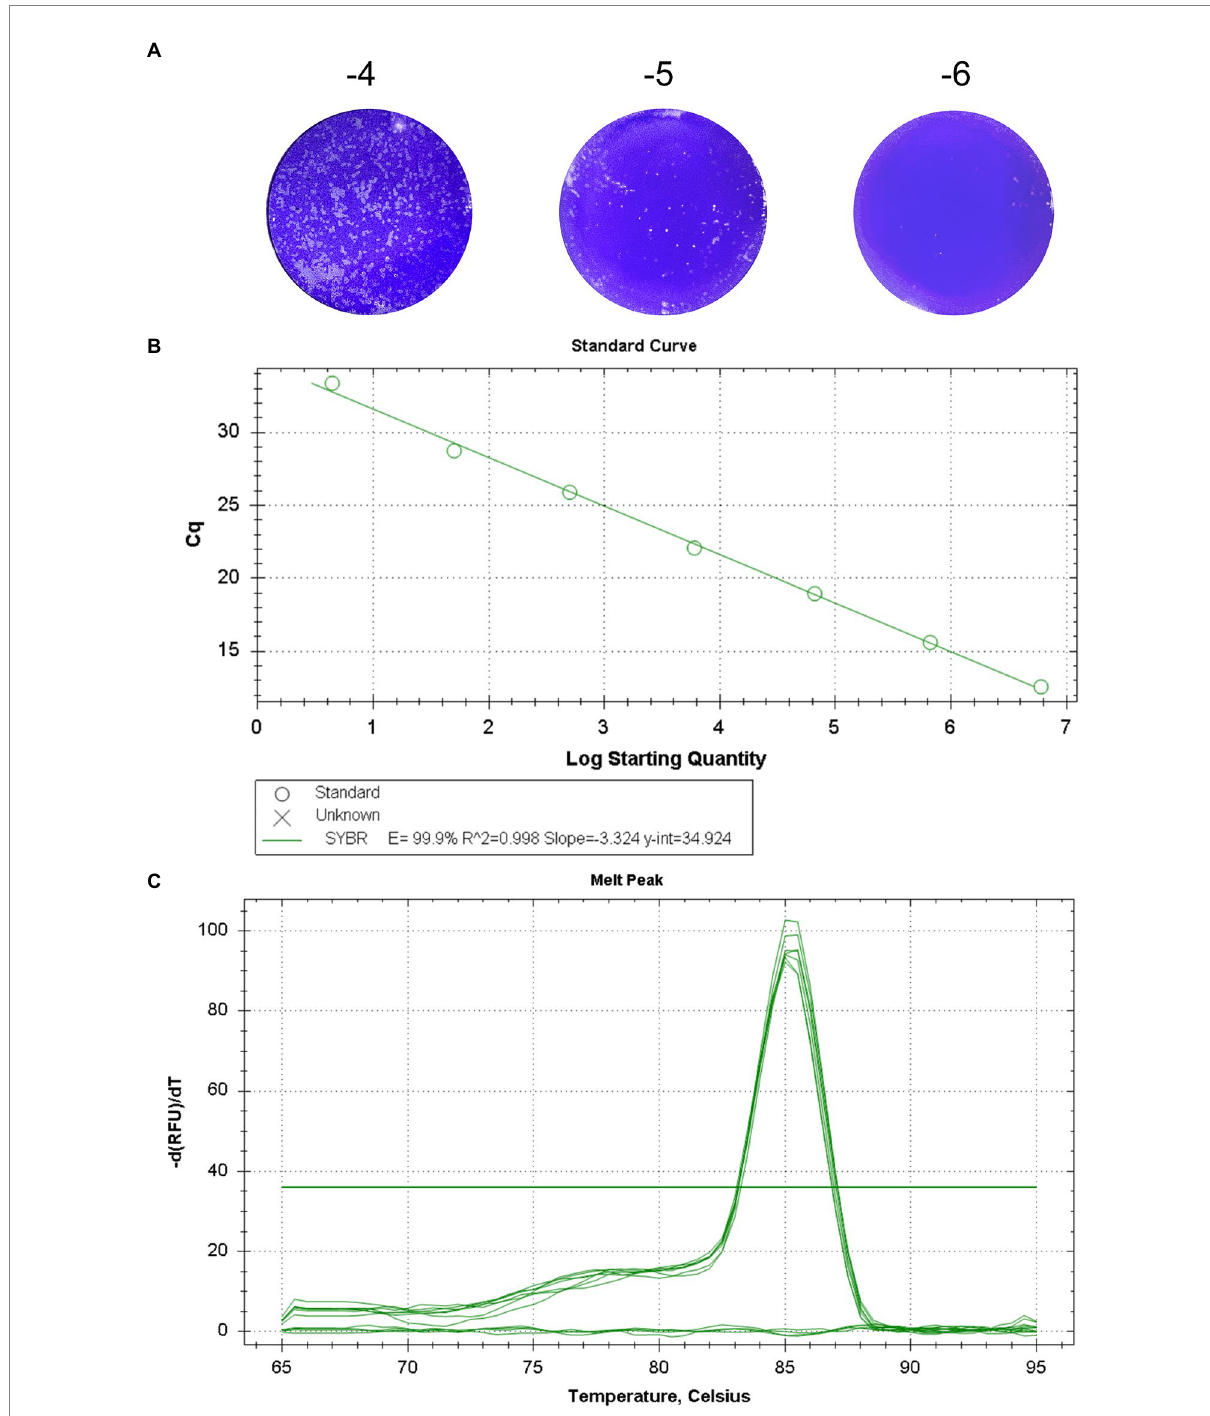
FIGURE 1 Standard curve of the real-time fluorescent quantitative PCR for GETV. (A) The titer of GETV was 7.73 × 10 6 PFU/mL. (B) Standard curve for GETV RNA generation using tenfold serial dilutions. The concentration range of RNA dilutions is 7.73 × 10 − 1 -7.73 × 10 6 . The equation for the standard curve was y = − 3.324 x + 34.924 R 2 = 0.998). y -axis, Cq value; x -axis, log value of the viral titers corresponding to the template RNA. (C) The melting curve showed that all the positive samples had the same melting temperature of 85.5 ± 0.5 ° C and a single